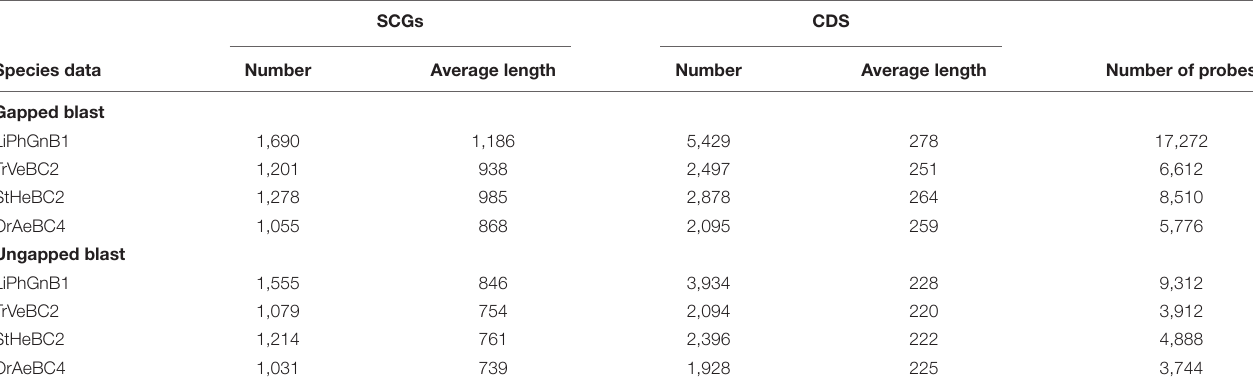
TABLE 1 | Number and characteristics of loci identified from the four Orobanchaceae